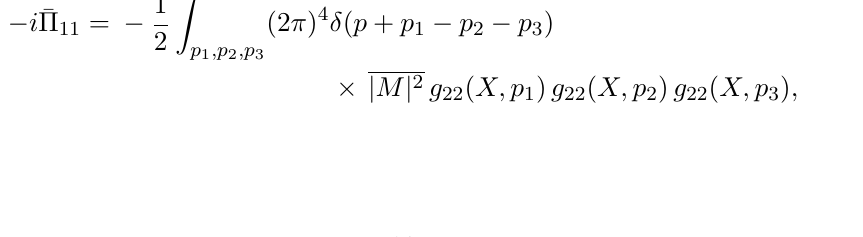
Figure 5 . Diagrams for (cid:5) a(cid:22);b(cid:23) 2 (cid:0) 2 propagators, separating the diagram into a product of an amplitude and a complex conjugate